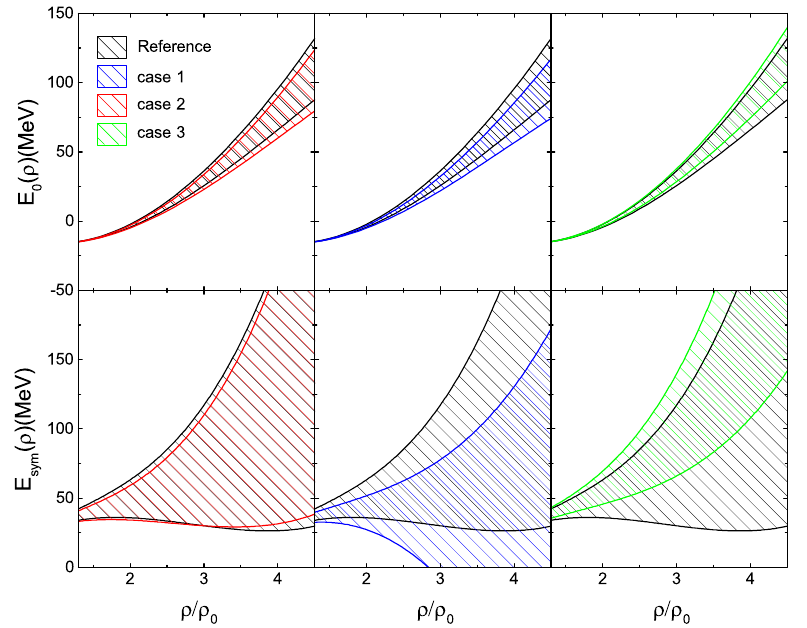
Figure 11. The 68% boundaries of nuclear symmetry symmetry ( bottom ) and SNM EOS ( top ) inferred from the neutron star radius data shown in Figure 9. Taken from